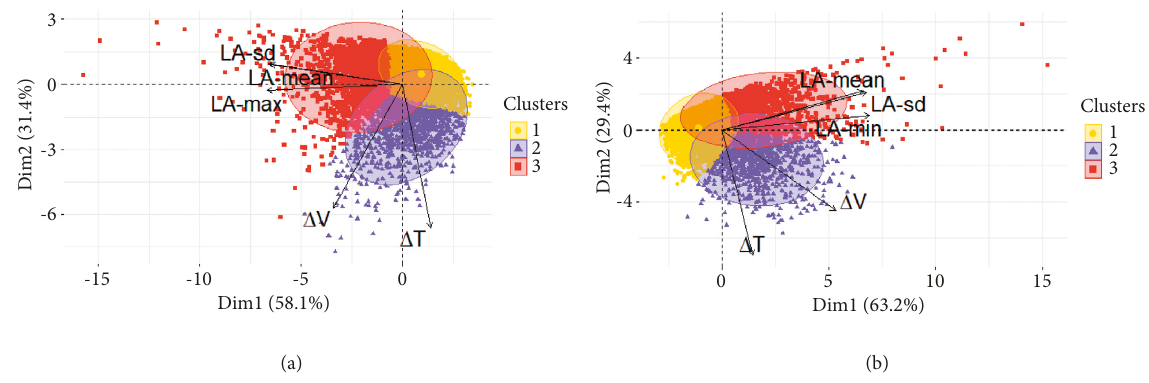
Figure 6: Bi-plots of (a) acceleration clusters and (b) braking clusters. Table 5: The correlation between the features and components (PC